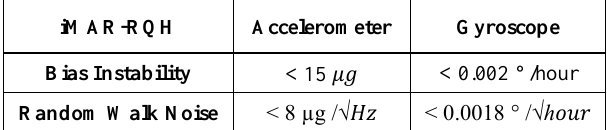
Table 3 . iMAR-RQH performance specification.